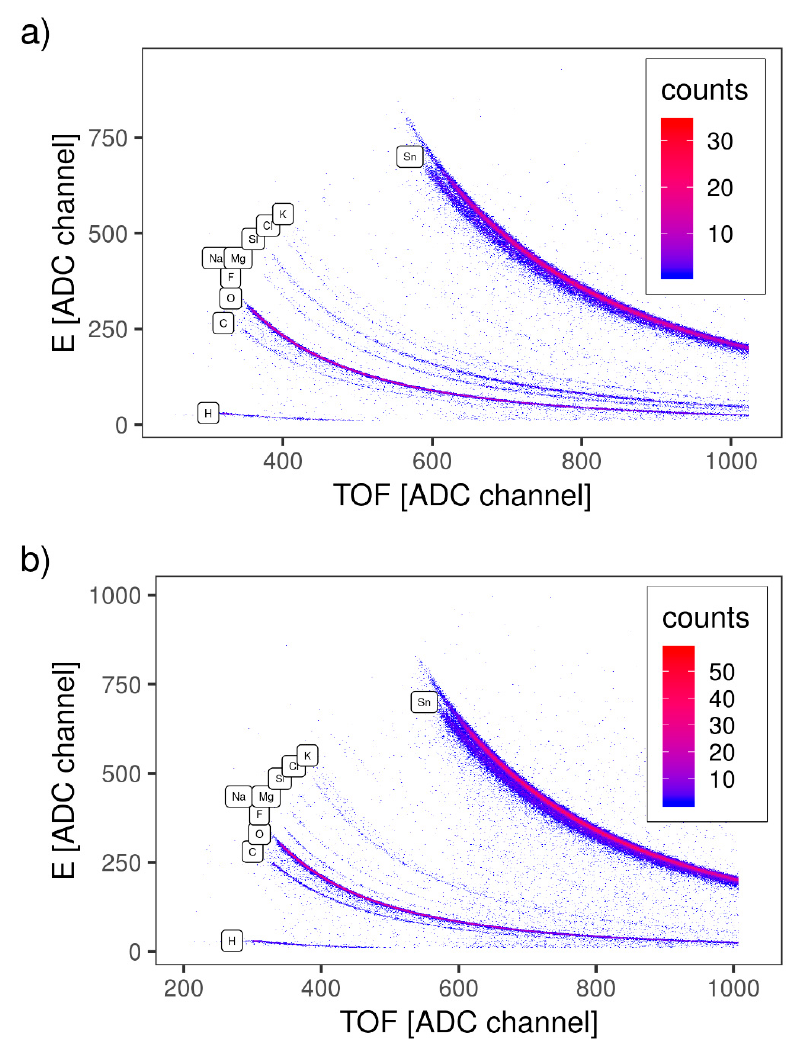
Figure 3. TOF-E map for SnO2 samples: ( a ) S-590 and ( b ) B-590. Traces of all detected elements are labelled. Table 3. Summary of TOF-ERDA elemental analysis (MC simulation). Total atomic content is normalized to 100%.